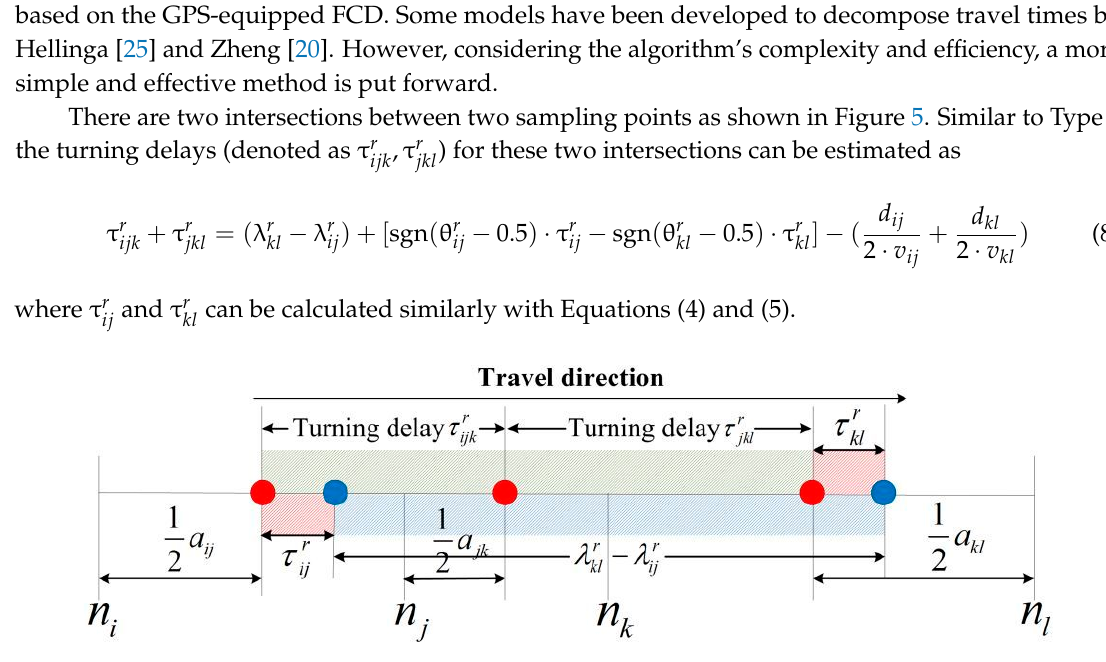
Figure 5. An illustration of sparsely sampling GPS data on the links for Type II.